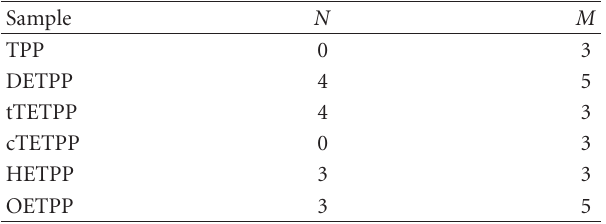
Table 2: Summary of porphyrin aggregation behaviour.